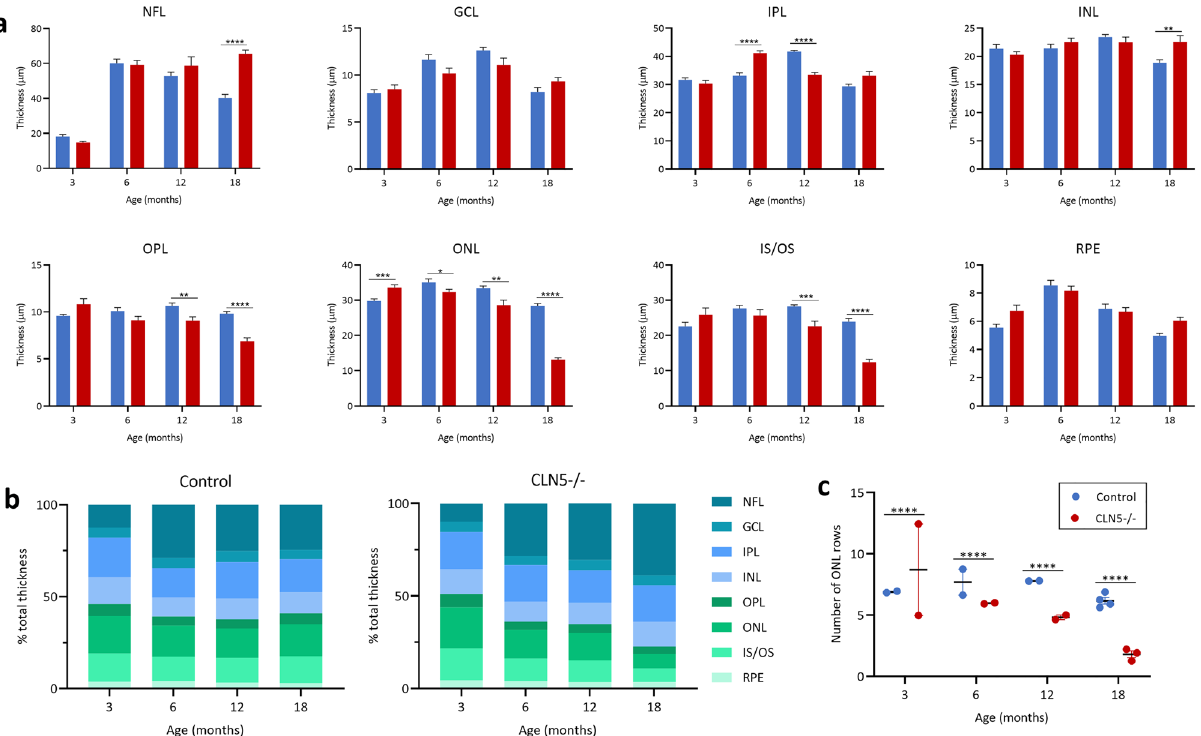
Figure 3. Thickness of individual retinal layers in healthy control and CLN5 −/− sheep at different ages. ( a ) Mean ± SEM thickness of individual layers in the central retina between control (n = 2–4, blue) and CLN5 −/− (n = 2–4, red) sheep at 3, 6, 12 and 18 months of age. ( b ) Percentage of total retinal thickness represented by each layer in control and CLN5 −/− sheep at various ages. ( c ) Mean ± SEM number of rows of cells in the outer nuclear layer (ONL) in control and CLN5 −/− sheep at various ages. * p < 0.05, ** p < 0.01, *** p < 0.001, **** p < 0.0001. NFL; nerve fibre layer, GCL; ganglion cell layer, IPL; inner plexiform layer, INL; inner nuclear layer, OPL; outer plexiform layer, IS/OS; inner and outer segments of photoreceptors, RPE; retinal pigment